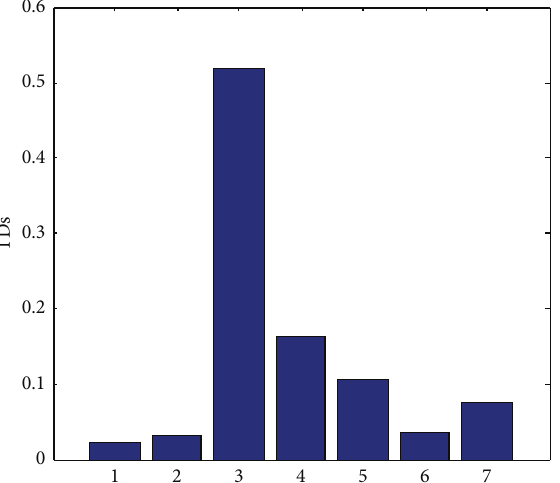
Figure 3: Detection indicators of the system with linear local